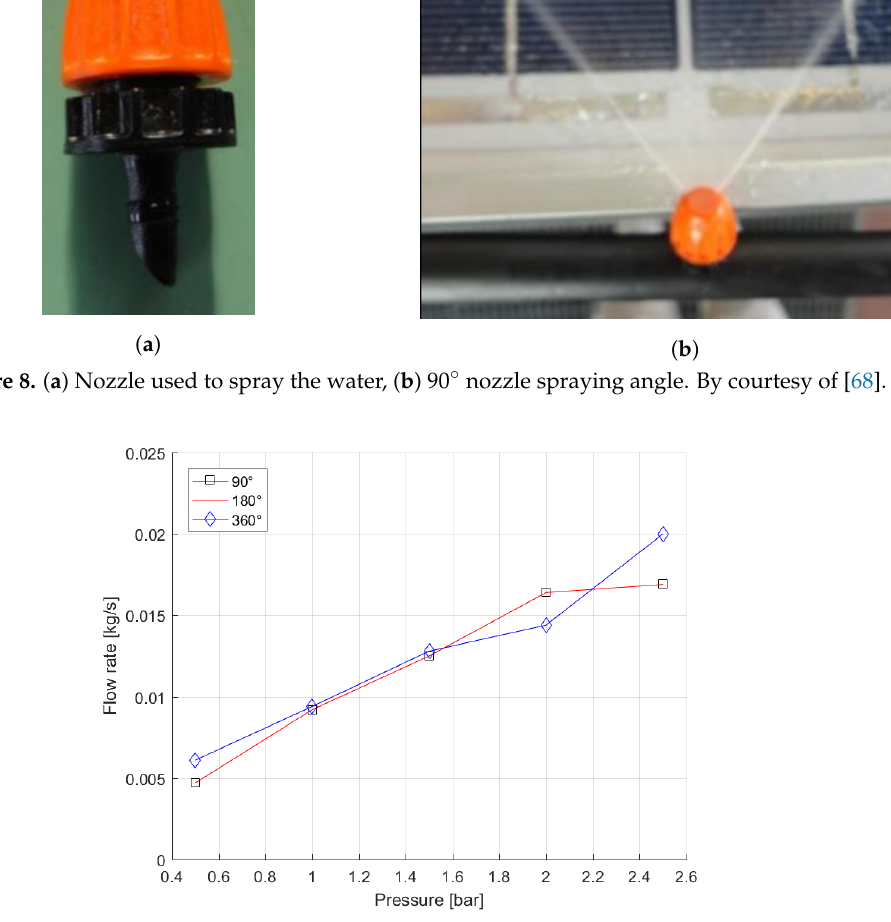
Figure 9. Inlet pressure vs. water mass flow rate characteristic for one nozzle with a spraying angle of 90 ◦ , 180 ◦ and 360 ◦ . By courtesy of